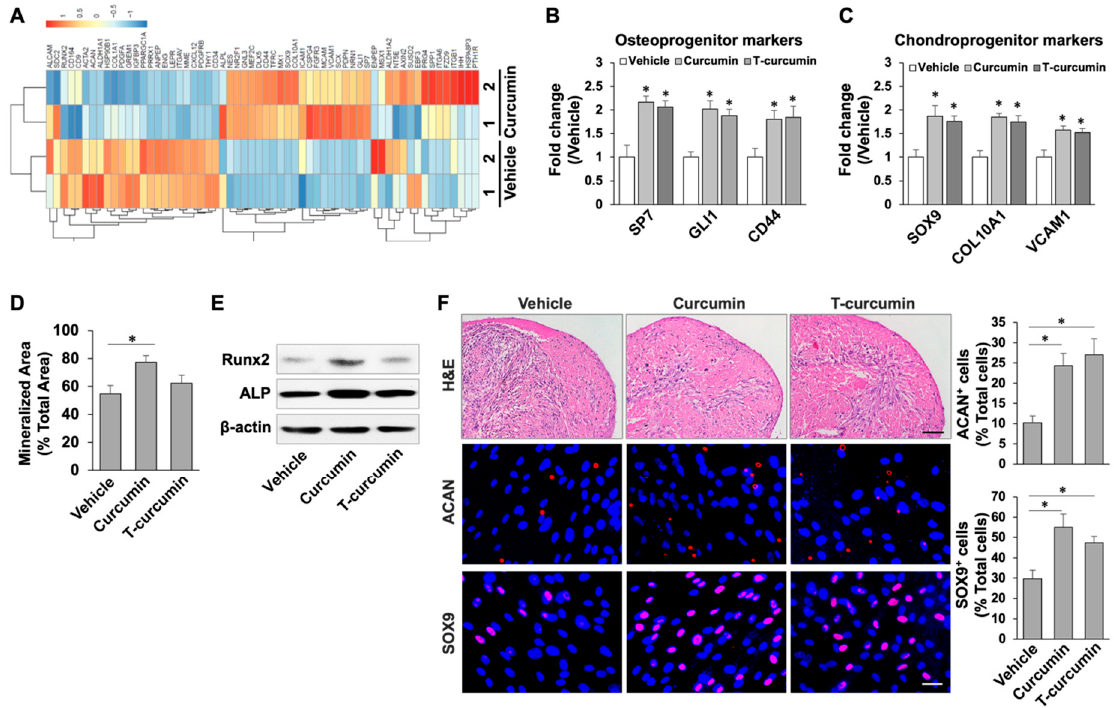
Figure 3. Curcumin increased the capabilities of osteogenic and chondrogenic differentiation in PDLSCs. ( A ) Heat map of RNA-seq analysis data showing the PDLSC function-related genes that were differentially regulated by curcumin treatment. ( B , C ) qPCR assay showed the significantly elevated levels of osteoprogenitor markers ( B ) and chondroprogenitor markers ( C ) in curcumin treated PDLSCs. ( D ) Alizarin red staining showed that curcumin treated PDLSCs has increased capacity to form mineralized nodules under osteoinductive conditions. ( E ) Western blot analysis showed the expression levels of the osteogenic genes RUNX2 and ALP were greatly increased in curcumin treated PDLSCs under osteoinductive conditions. β -actin was used as a loading control. ( F ) Histological analysis showed chondrogenic differentiation of vehicle and curcumin treated PDLSCs. Scale bar, 25 μ m. IF staining showed increased ACAN + and SOX9 + cells after curcumin treatment in PDLSCs. Scale bar, 25 μ m. * p < 0.005. Error bars represent the s.d. from the mean values.